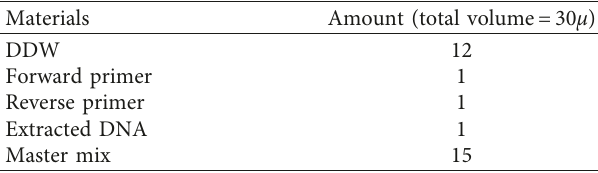
Table 2: Materials required for PCR.